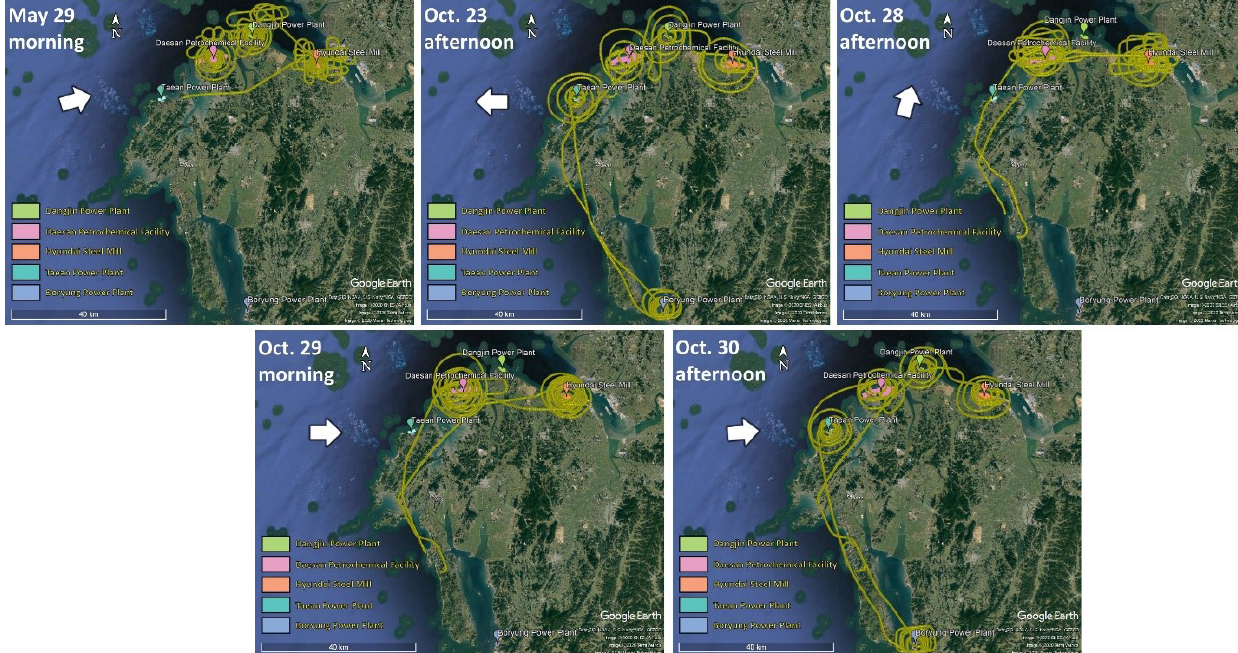
Figure 1. Composite Google Earth images (© Google Earth) showing research flight tracks over the Daesan petrochemical facility, the Dangjin and Boryeong thermal power plants, Hyundai steel mills, and Taean coal power plants during the airborne study conducted in summer (May–June 2019) and fall (October 2019). The white arrow in each plot represents the mean wind direction during the flight. Only those flights for which wind direction measurements were available are shown. Table 1. Summary of research flights with VOC measurements during the summer (May–June) and fall (October) aircraft campaigns in South Korea. Note: all times are given in local time